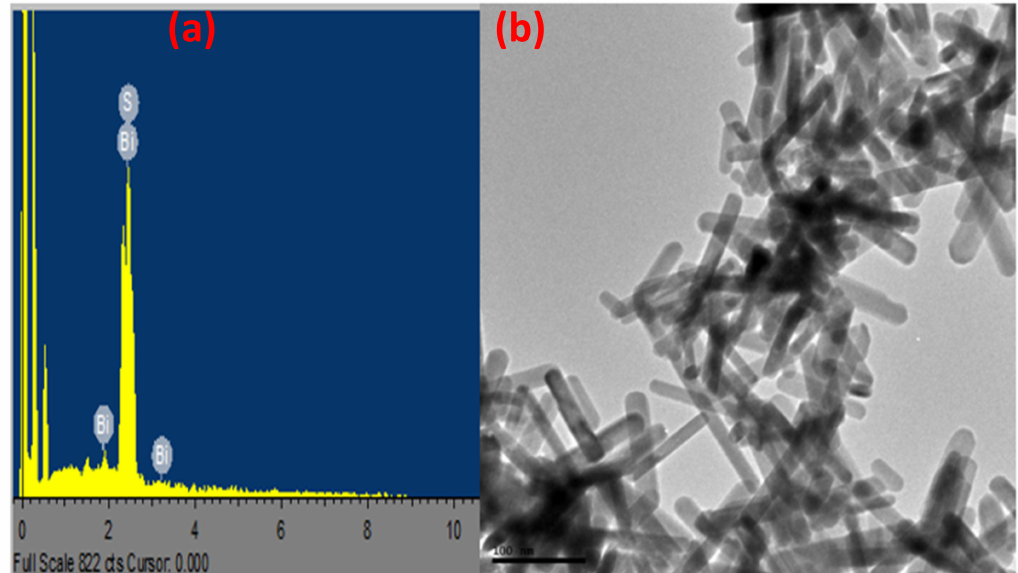
Figure 3. ( a ) EDS spectrum of bismuth sulphide showing the presence of bismuth and sulphur only in the as-prepared nanoparticles and ( b ) TEM spectrum of bismuth sulphide showing a nanorod internal